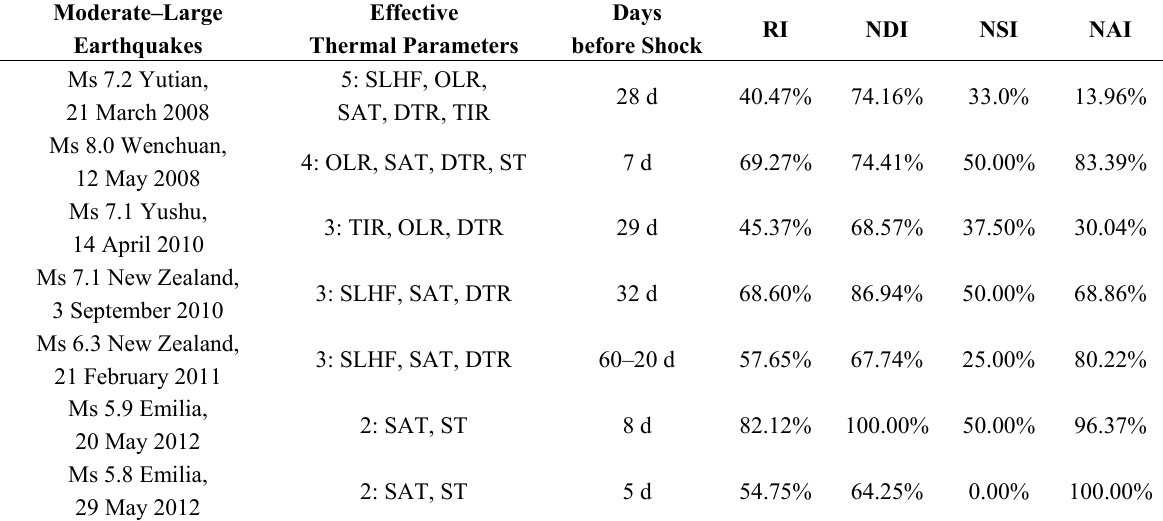
Table 1. Typical results of earthquake anomaly recognition with multiple thermal